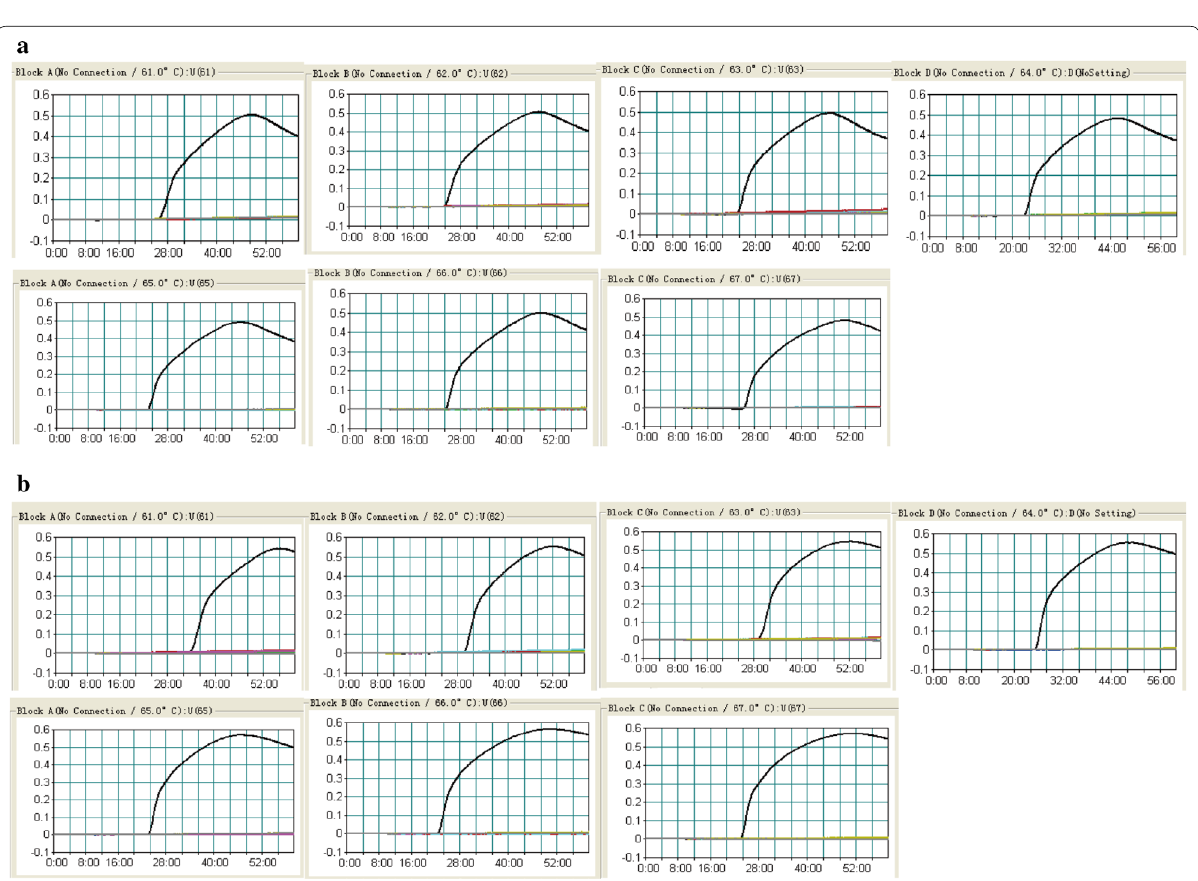
Fig. 4 Optimal reaction temperature for M. abscessus - and M. massiliense -primer sets. The standard LAMP reactions for detection of M. abscessus ( a ) and M. massiliense ( b ) were monitored by real-time measurement of turbidity and the concentration of M. abscessus - and M. massiliense -DNA was 100